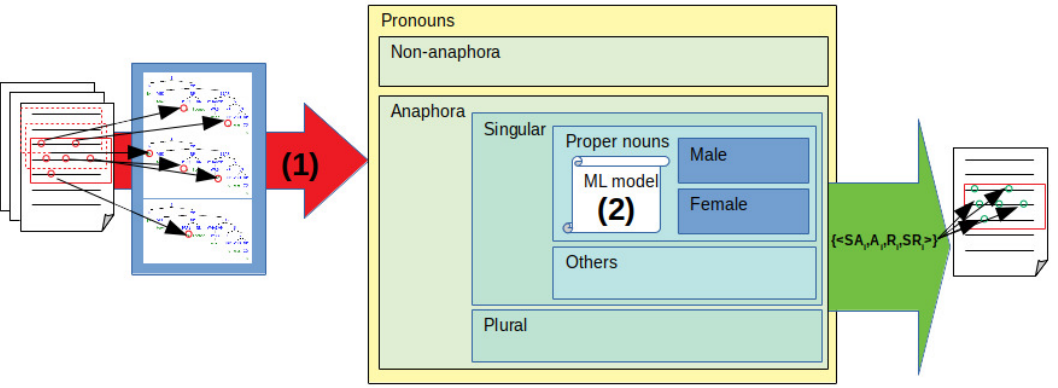
Figure 3. A scheme of the GEARS workflow, with highlighted the 2 contributions proposed in this paper: improved rules for anaphora resolution (1) and proper noun gender recognition